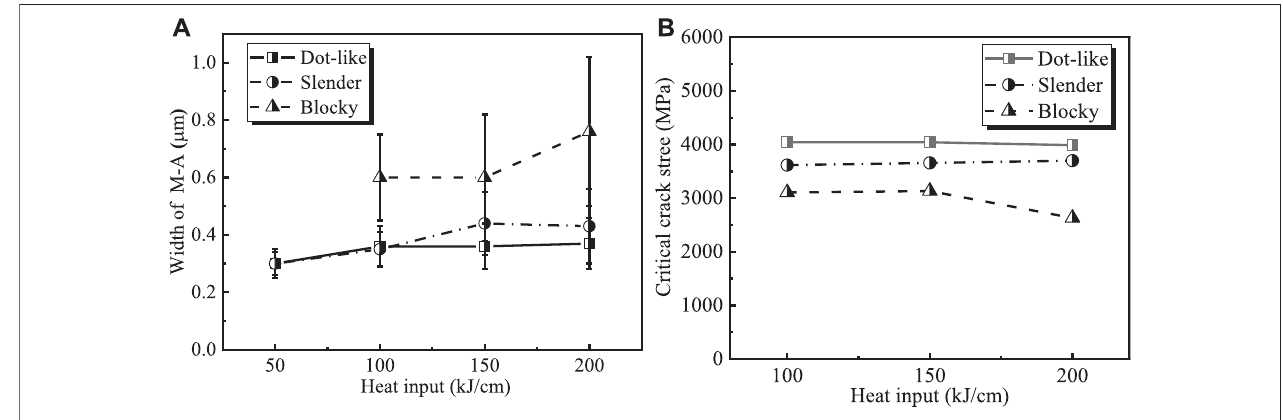
FIGURE 14 | Effect of heat inputs on (A) widths and (B) critical crack stresses of the M – A constituents in different